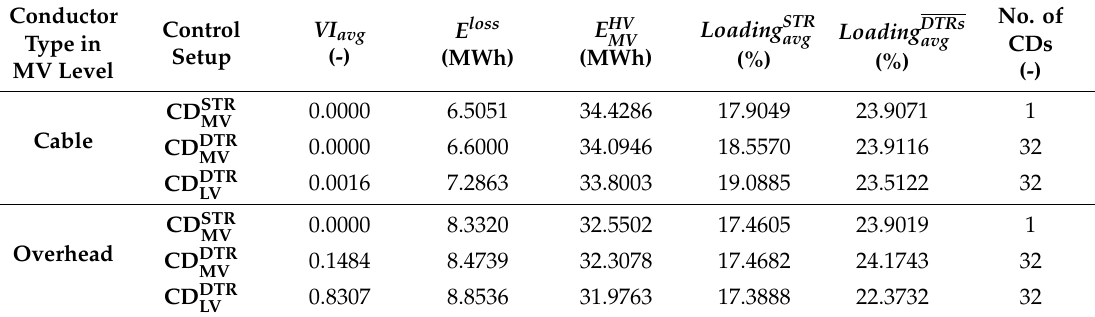
Table 4. Criteria used for the evaluation of di ff erent CD locations within the distribution grid with cable or overhead conductors in MV